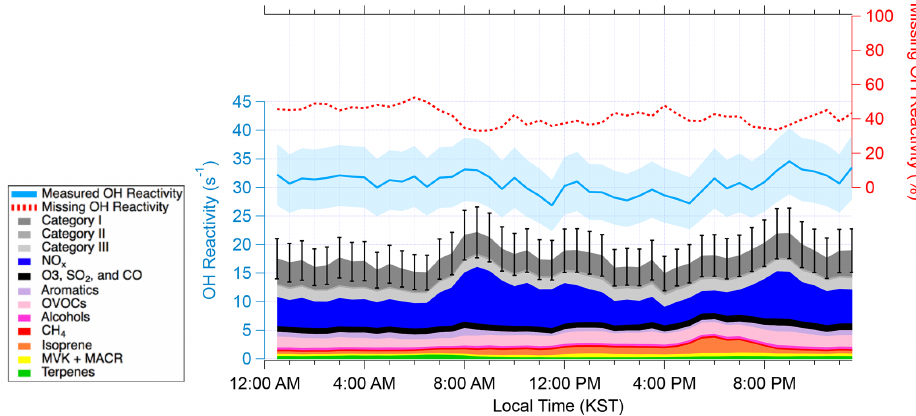
Figure 2. The diurnal average of OH reactivity from 15 May–7 June 2016. The measured and calculated OH reactivity are on the left axis. The blue shading represents uncertainty in the measured OH reactivity. The black bars represent the propagated uncertainty in calculated OH reactivity. The missing OH reactivity in the percentage scale can be read using the right